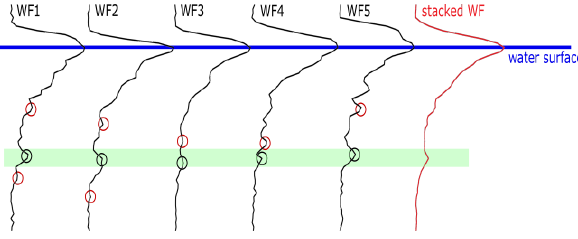
Figure 6: Basic principle of waveform stacking applied to ALB pulse echo waveforms (Mader et al., 2019)